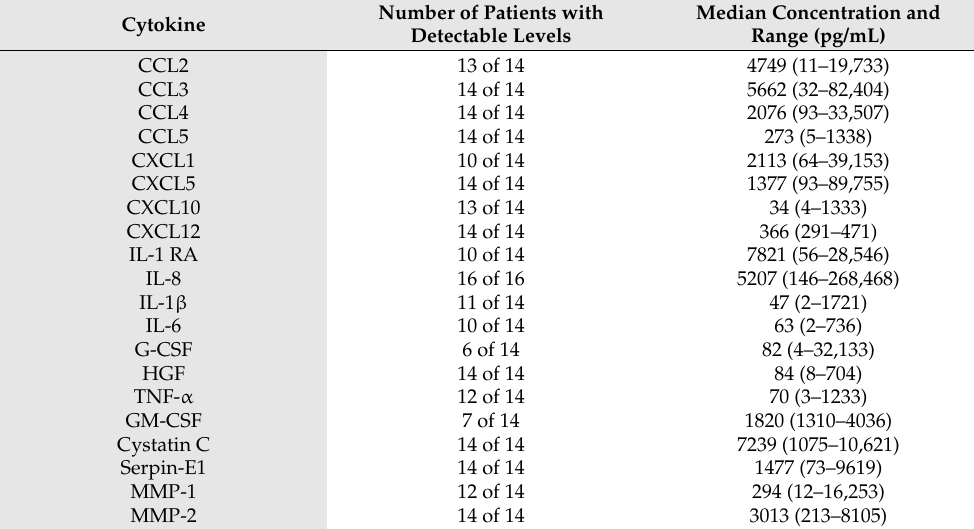
ratio to the untreated control. Medians of the ratios from samples with detectable levels were used in the Wilcoxon signed-rank test for each cytokine (GM-CSF and G-CSF are